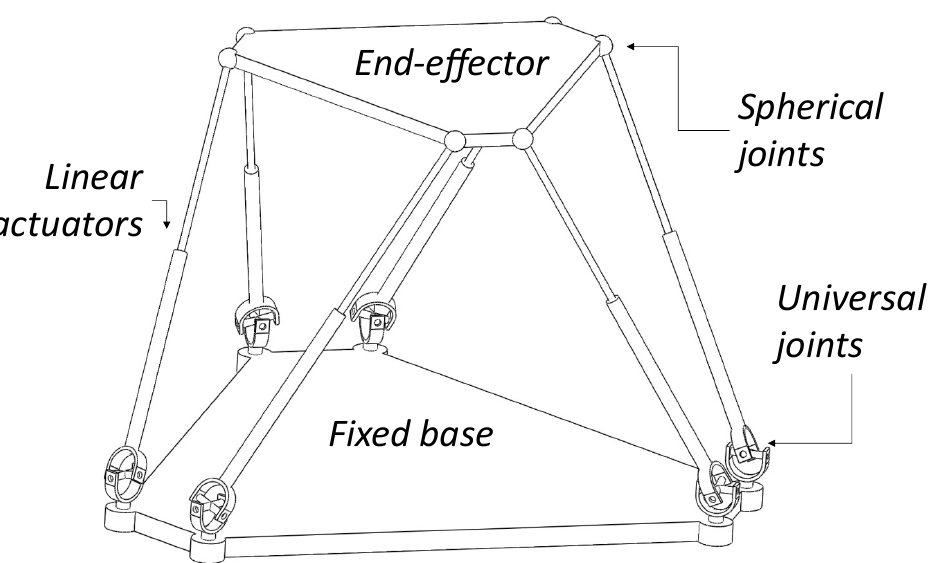
Figure 1. General scheme of the 6–6 degree-of-freedom (DOF) Stewart platform